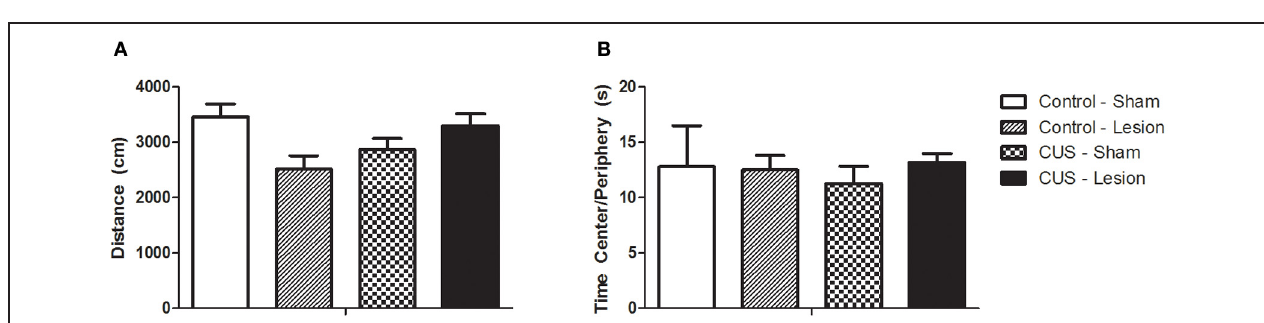
FIGURE 3 | Anxiety-like behavior measured in the Elevated Plus-Maze. (A) Percentage of time spent in open arms. (B) Mean number of entrances in the open and closed arms. CUS, chronic unpredictable stress; ∗ p < 0 . 05; ∗∗ p < 0 . 01. Results are presented as Mean + SEM.